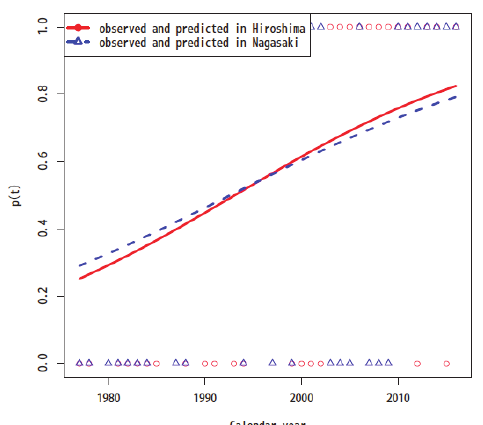
Fig. 14. Observed and predicted probability of appearance for